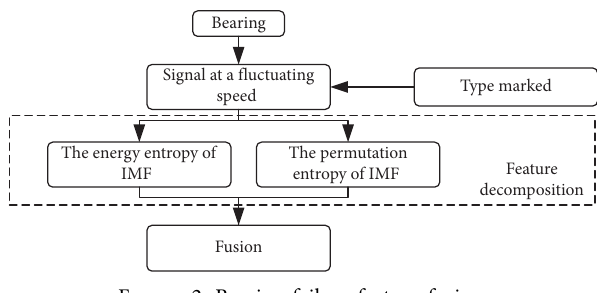
Figure 2: Bearing failure feature